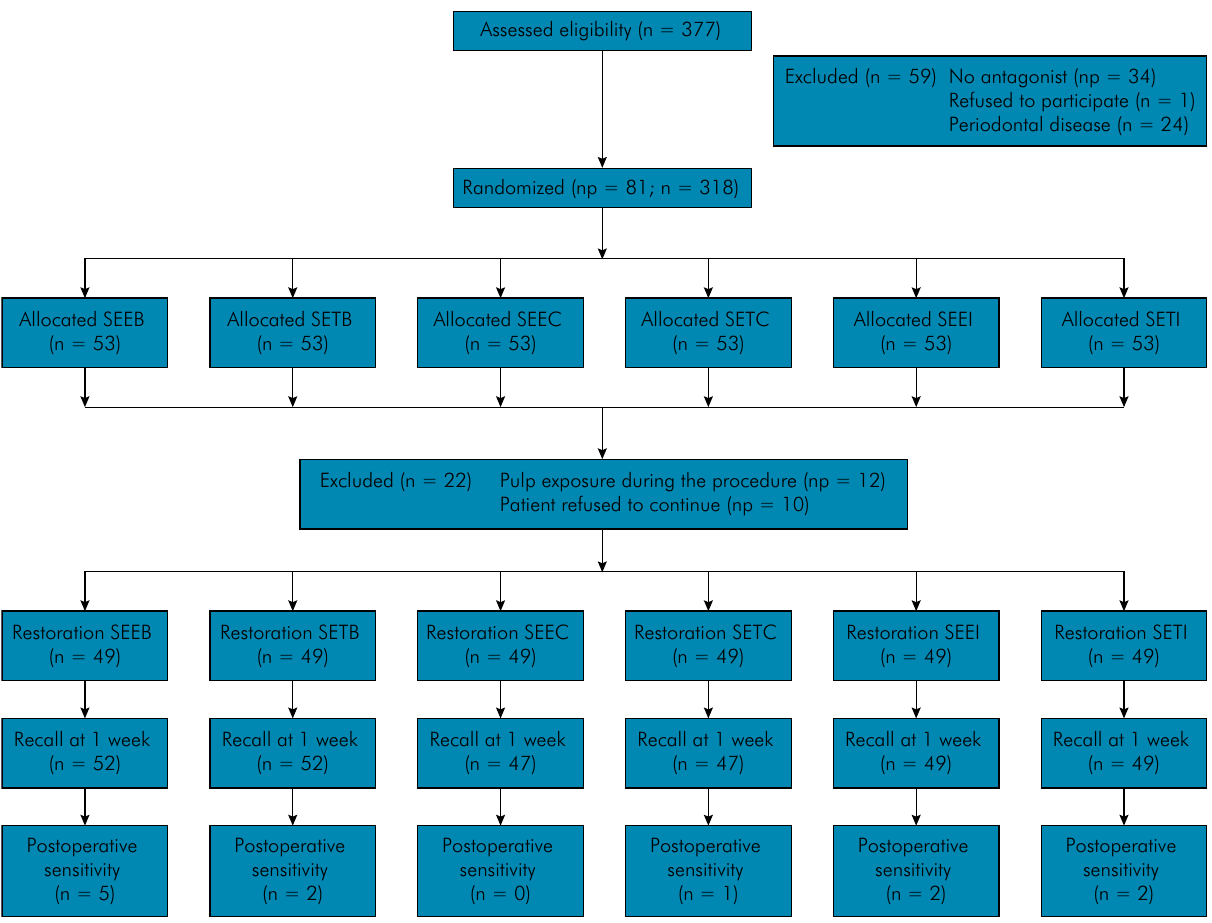
Figure. Participant flow diagram in the different phases of the study design. Np = number of participants; N = number of